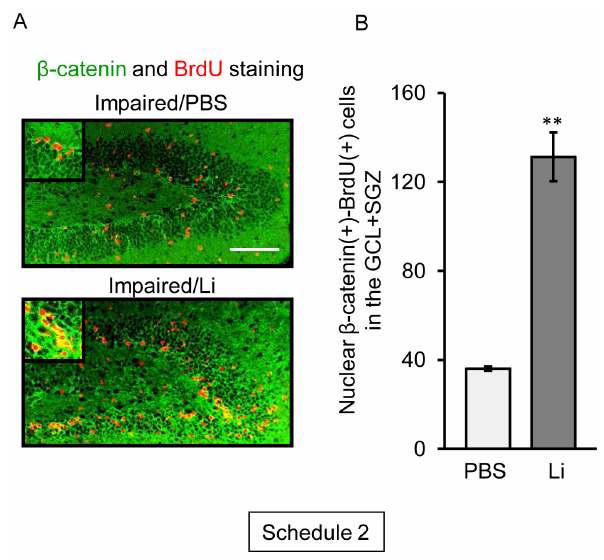
Figure 7. Lithium (Li)-induced nuclear translocation of b - catenin in BrdU( + ) cells generated following neuronal loss. Animals were given either lithium carbonate (100 mg/kg, i.p.) or PBS with BrdU on day 2 post-treatment with TMT, subsequently given once a day either lithium carbonate or PBS on days 3 and 5, and then decapitated on day 30 post-treatment for preparation of sagittal hippocampal sections, which were then stained with antibodies against b -catenin and BrdU (Schedule 2). ( a ) Fluorescence micrographs show localization of BrdU ( red ) and b -catenin ( green ) in the dentate gyrus of the 2 groups (impaired/PBS, impaired/Li 2 CO 3 ). Scale bar=100 m m ( b ) Graph denoting the number of BrdU( + ) cells with nuclear b -catenin in the GCL + SGZ of each group. Values are expressed as the mean 6 S.E., calculated from 5 animals. ** P , 0.01, significant difference between the values obtained for PBS and Li groups.